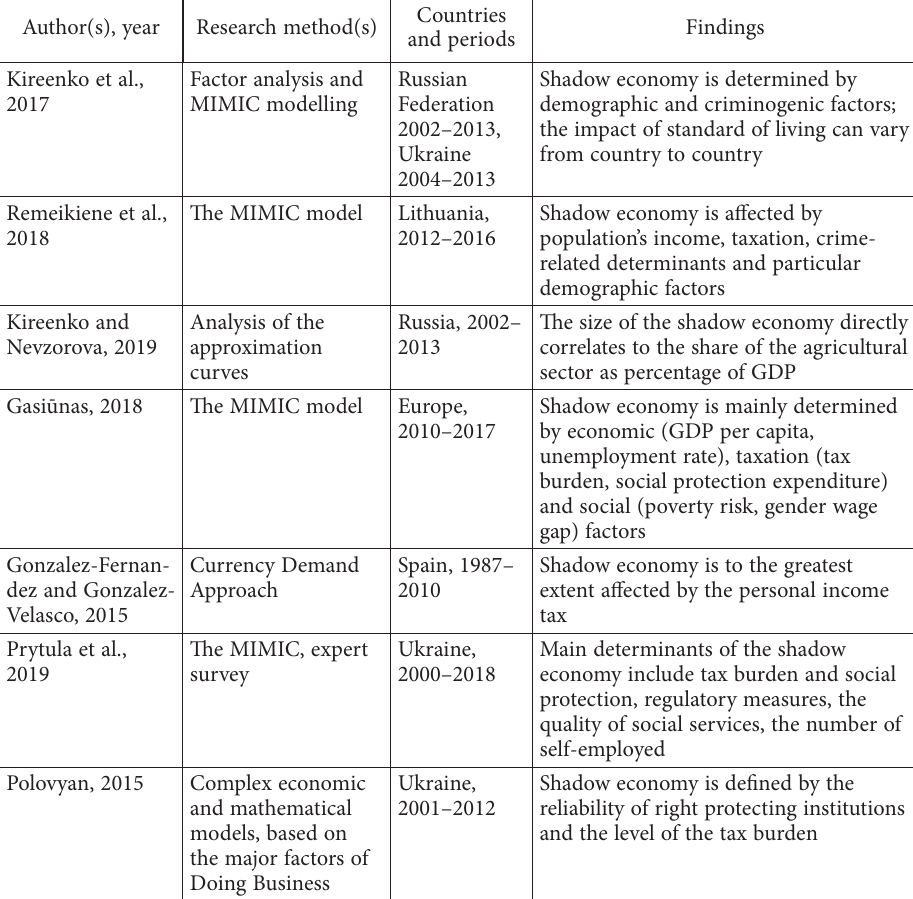
Table 1. The review of some previous findings on the determinants of the shadow economy in regions (source: compiled by the